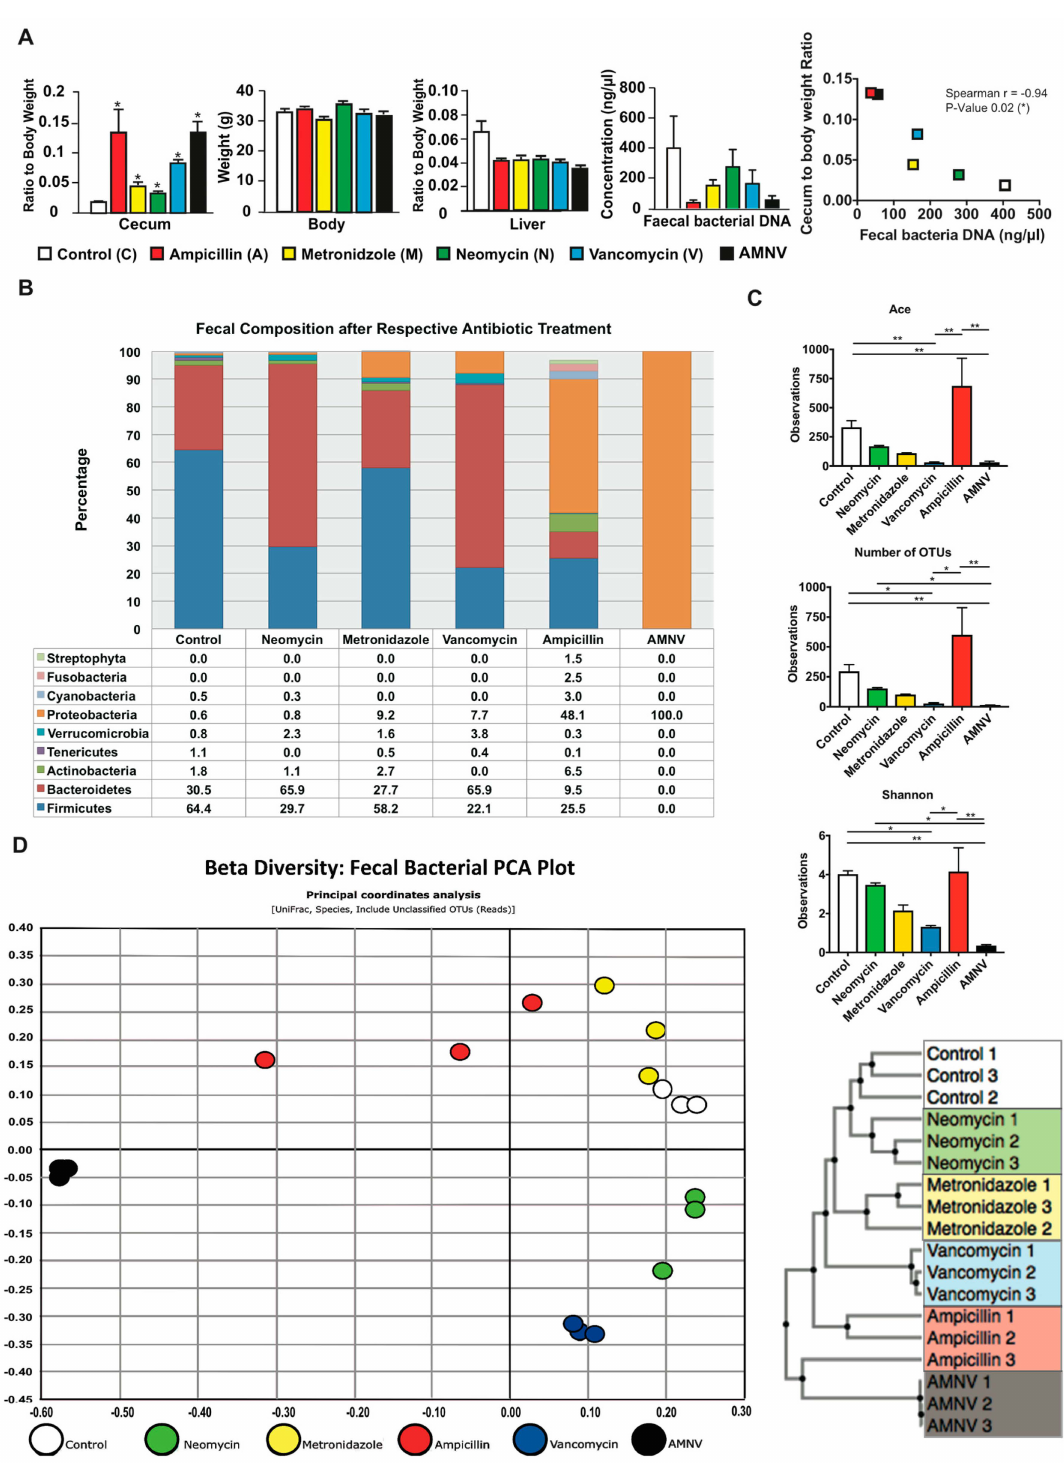
Figure 1. Phenotypic and fecal analysis of four-week antibiotic-treated specific pathogen-free (SPF) mice. ( A ) Average cecum to body weight ratio, body weight, liver to body weight ratio, bacterial DNA concentration in the extracts of faeces collected by direct defaecation, and faecal bacteria DNA load versus cecum to body weight ratio correlation plot are presented after the mentioned antibiotic treatments ( n = 5, except for control cecum weight with n = 4, all faecal analysis with n = 3). Cecum and liver weight were normalized to respective average body weight before performing statistical analysis. Statistical analysis was performed using two-tailed Mann-Whitney test for all presented data except for the correlation between faecal bacteria DNA load and cecum to body weight ratio, which was